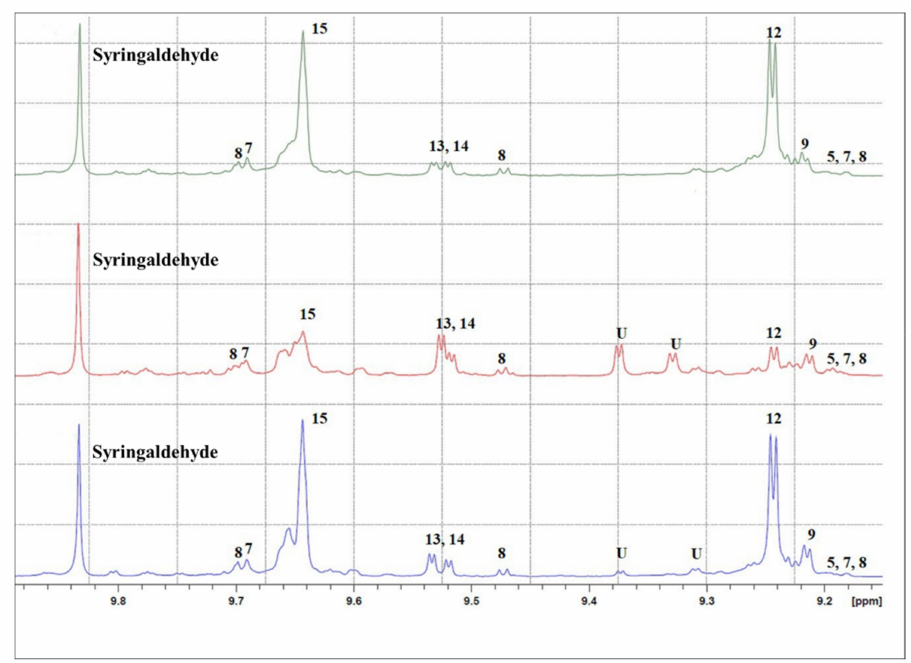
Figure 5. 1 H NMR spectra of EVOO 1 (blue), 2 (red) and 3 (green) in the 9.15–9.9 region. Syringaldehyde is the internal standard for quantification. Signals were identified according the literature data, and numeration refers to: (5) oleomissional, (7) 5S, 4R-oleuropeindial, (8) 5S, 4S-oleuropeindial, (9) oleacein (3,4-DHPEA-EDA), (12) oleocanthal (p-HPEA-EDA), (13) p-HPEA-EA (ligstroside aglycone), (14) 3,4-DHPEA-EA (oleuropein aglycone), (15) elenolic acid and U = unknown signal. More details in Table S5.